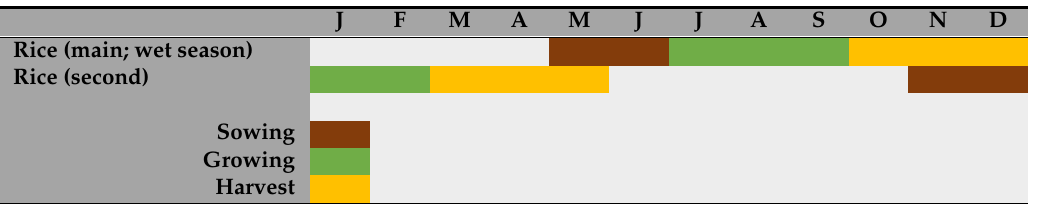
Table 1. FAO Myanmar rice crop